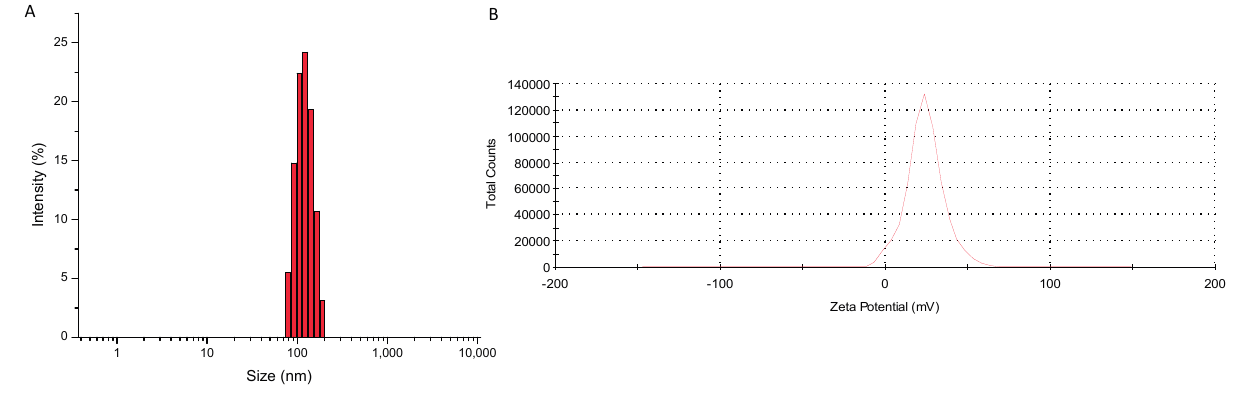
Figure 4. Physical characterization of GCV-PCL-chitosan micelles, ( A ) size analysis reported by DLS and ( B ) charge reported by